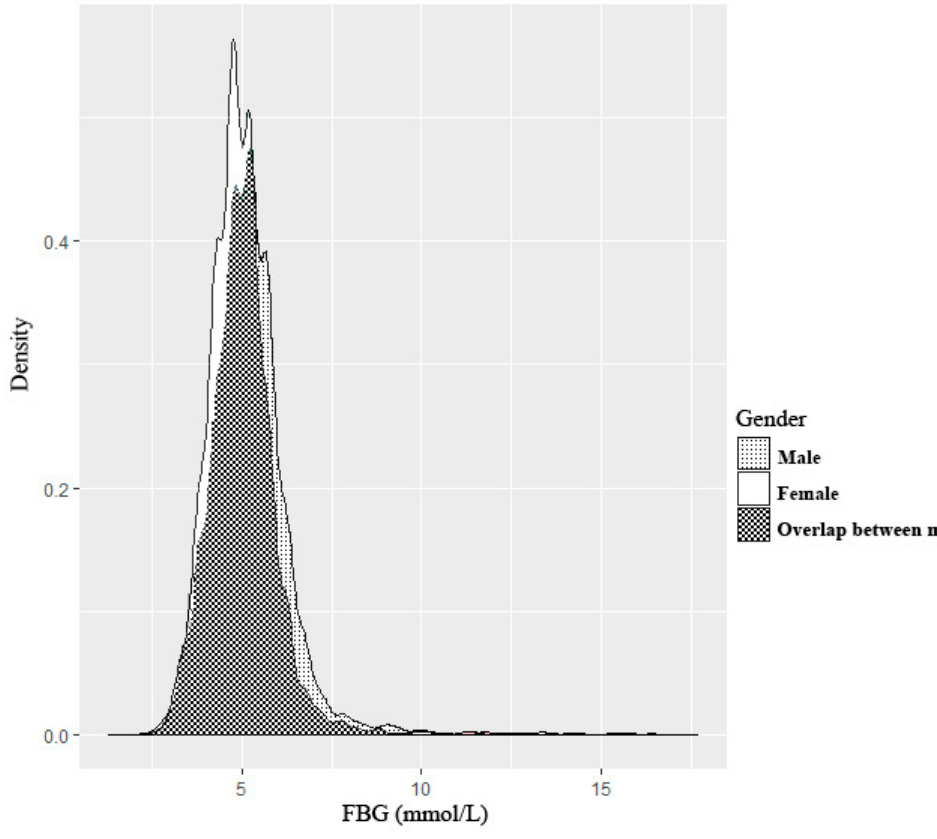
Figure 2. The distribution of FBG for males and females (density diagram).